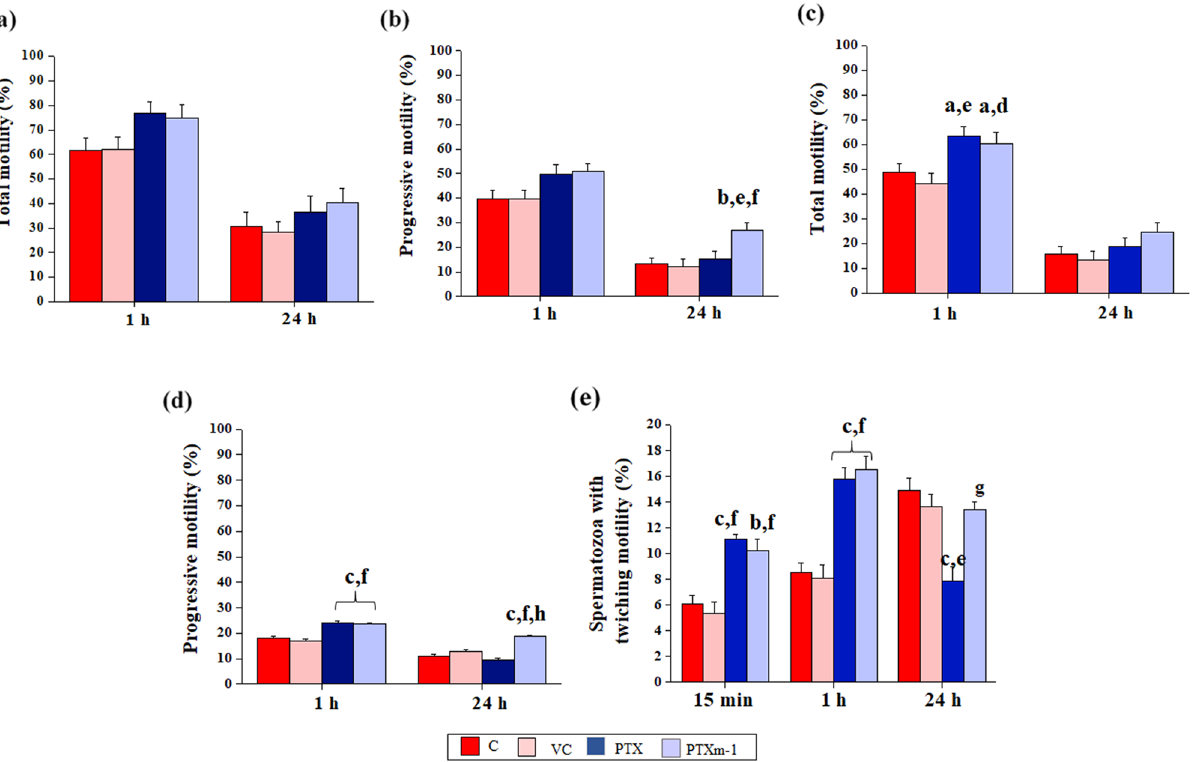
Figure 5. Effect of PTX (1 mM) and PTXm-1 (0.25 mM) on the sperm motility in the normozoospermic and the asthenozoospermic samples processed by swim-up technique at 1 and 24 h intervals. Percentage of ( a ) total and ( b ) progressively motile spermatozoa in the normozoospermic semen samples (N = 84). Percentage of ( c ) total and ( d ) progressively motile spermatozoa in the asthenozoospermic semen samples (N = 28). ( e ) Twitching motility of the testicular spermatozoa (N = 8). The error bar represents standard error to mean. a: P < 0.05; b: P < 0.01, c: P < 0.001 compared to C (control); d: P < 0.05, e: P < 0.01, f: P < 0.001 compared to VC (vehicle control); g: P < < 0.01, h: < 0.001 compared to PTX. C: control; VC: vehicle control; PTX: pentoxifylline; PTXm- 1: modified pentoxifylline.